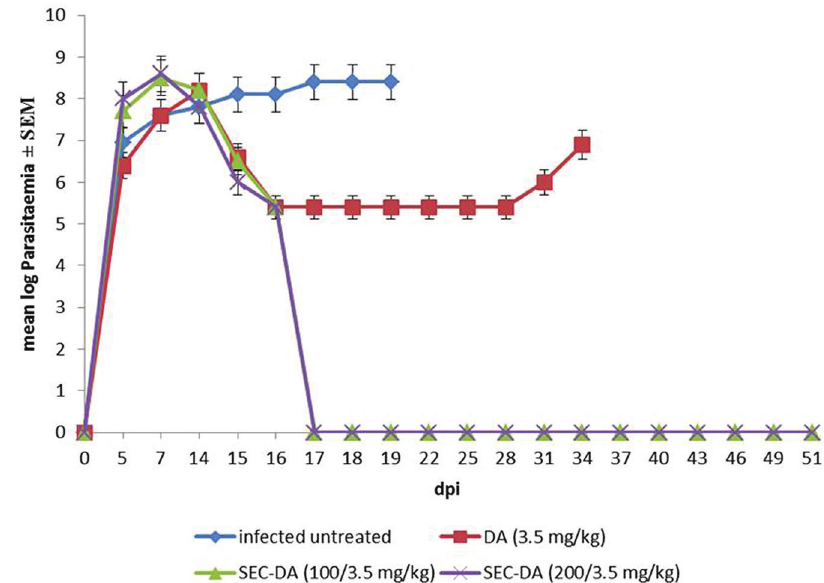
FIGURE 1 - Mean log parasitaemia in dogs infected with T. b brucei and treated with combinations of SEC-DA and DA monotherapy. Dogs were infected on day 0 and treatment started 14 d.p.i. All infected untreated dogs died before 22 d.p.i. Data collection on parasitaemia was terminated for a group as soon as relapse was recorded for that